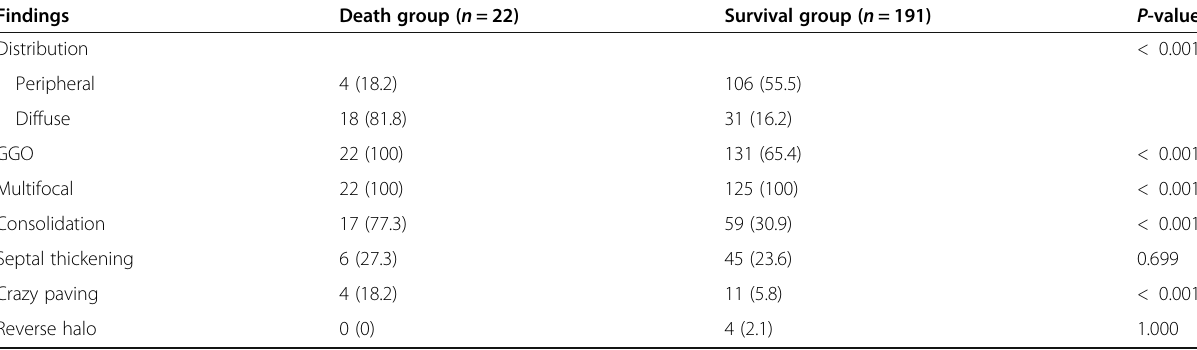
Table 2 CT image